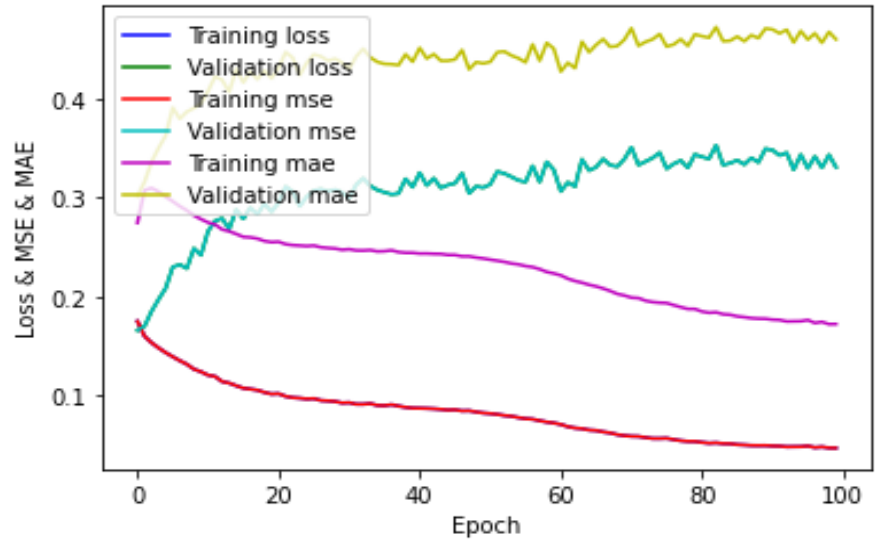
Figure 19. Loss/MSE/MAE plot for hologram dataset. Table 8. Evaluation metrics for test set of the hologram Table 8. Evaluation metrics for test set of the hologram dataset.